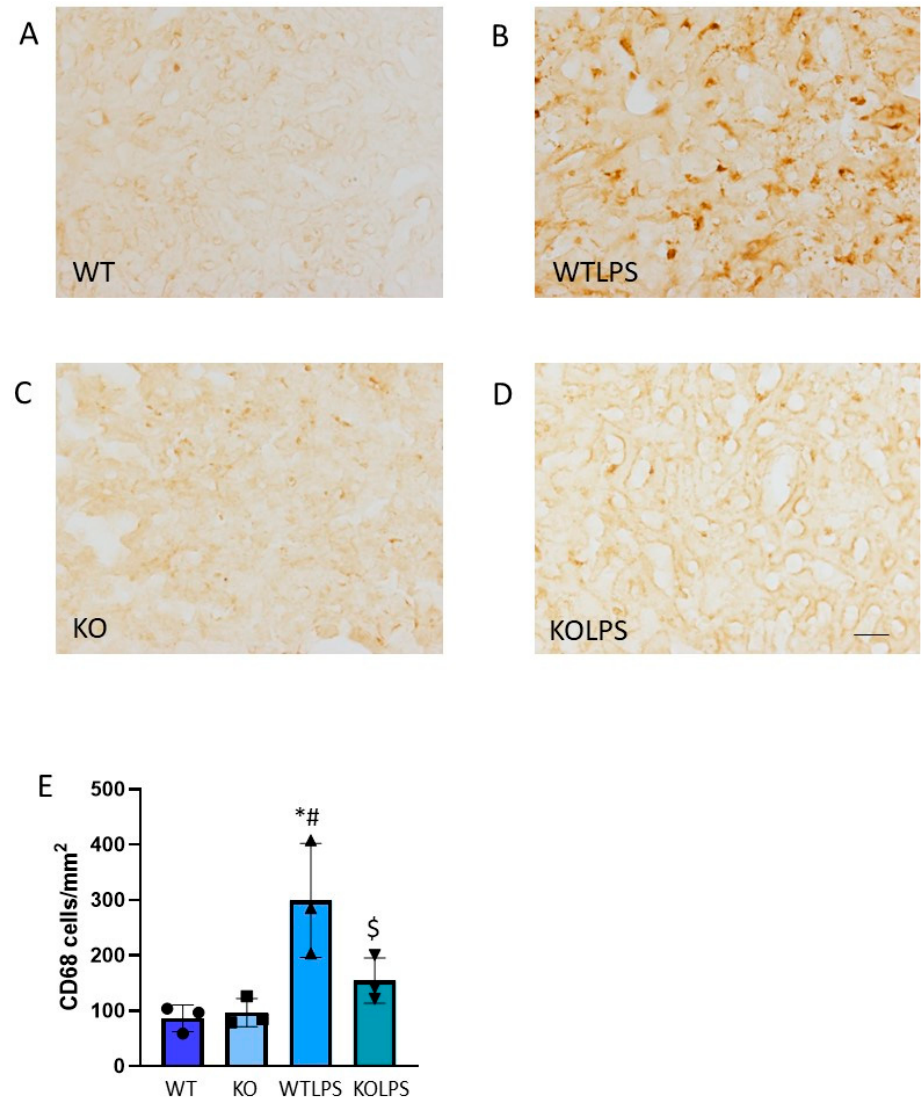
Figure 7. CD68 expression in liver. Representative immunostaining from sections of the different treatments assayed. WT ( A ) and KO ( C ) animals show a normal pattern of CD68 expression; however, the treatment with LPS produces a strong induction of CD68-positive cells in WT animals ( B ). Absence of Gal3 clearly reduces this effect ( D ). Scale bar: 100 μ m. ( E ) Quantification of the density of CD68 positive cells in liver. Results are mean ± SD of N = 3 animals, expressed as number of cells per mm2. Statistical significance (one-way ANOVA followed by the LSD post hoc test for multiple comparisons): * -compared with WT group; # -compared with KO group; $ -compared with WTLPS group; p < 0.01. Abbreviations: WT, wild type mice; WTLPS, wild type mice treated with LPS; KO, Gal3 knockout mice; KOLPS, Gal3 knockout mice treated with LPS.